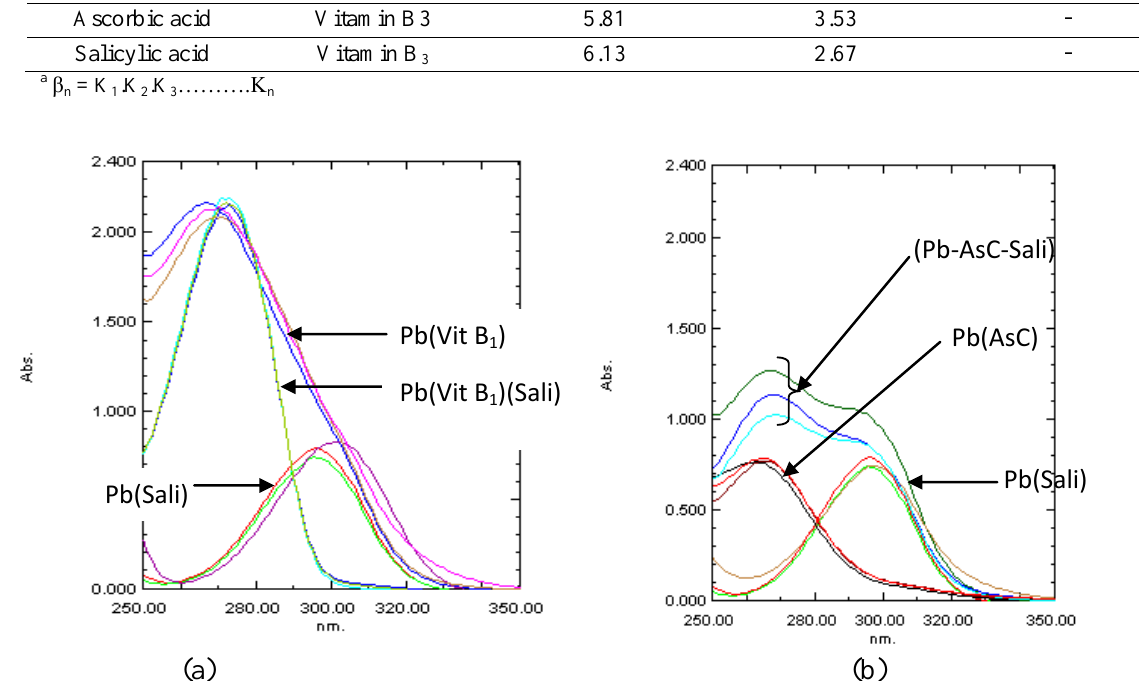
Figure 3: (a) UV absorption spectra for binary complexes; Pb(Vit B1), Pb(Sali) and Pb(Vit B1-Sali) systems at three different pH values; 4, 5 and 6. (b):UV absorption spectra for binary complexes; Pb(AsC), Pb(Sali) and Pb(AsC-Sali) systems at three different pH values; 4, 5 and